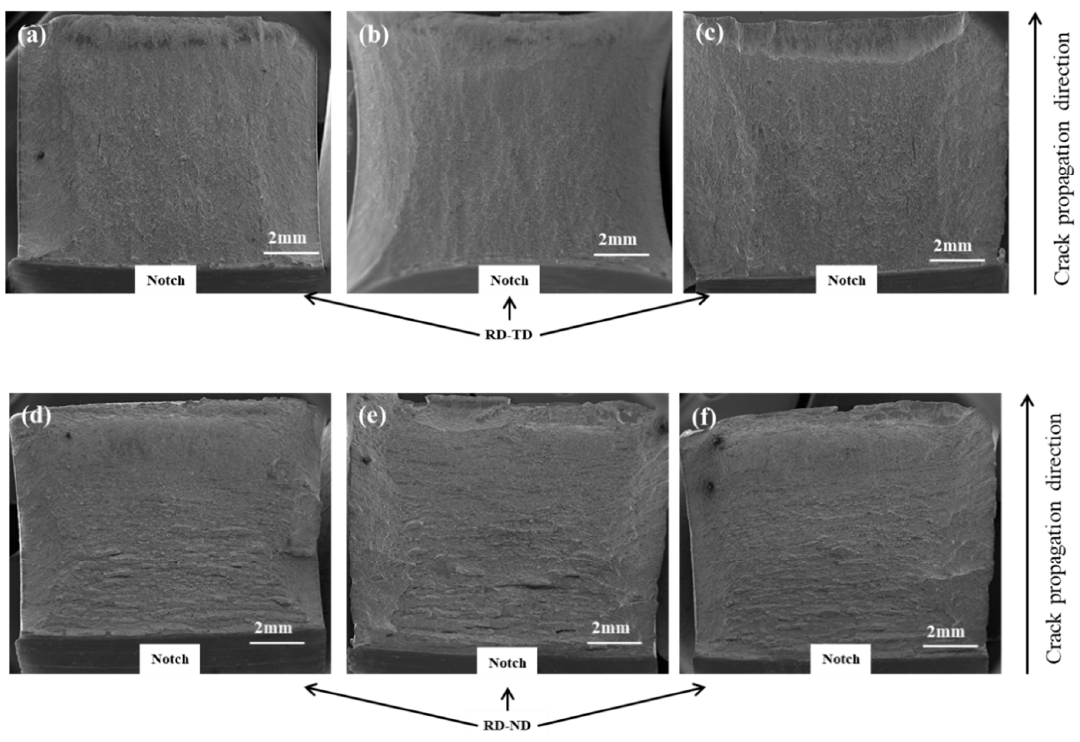
Figure 7. Macromorphology of the impact fractures: ( a – c ) RD-TD specimen; ( d – f ) RD-ND specimen.